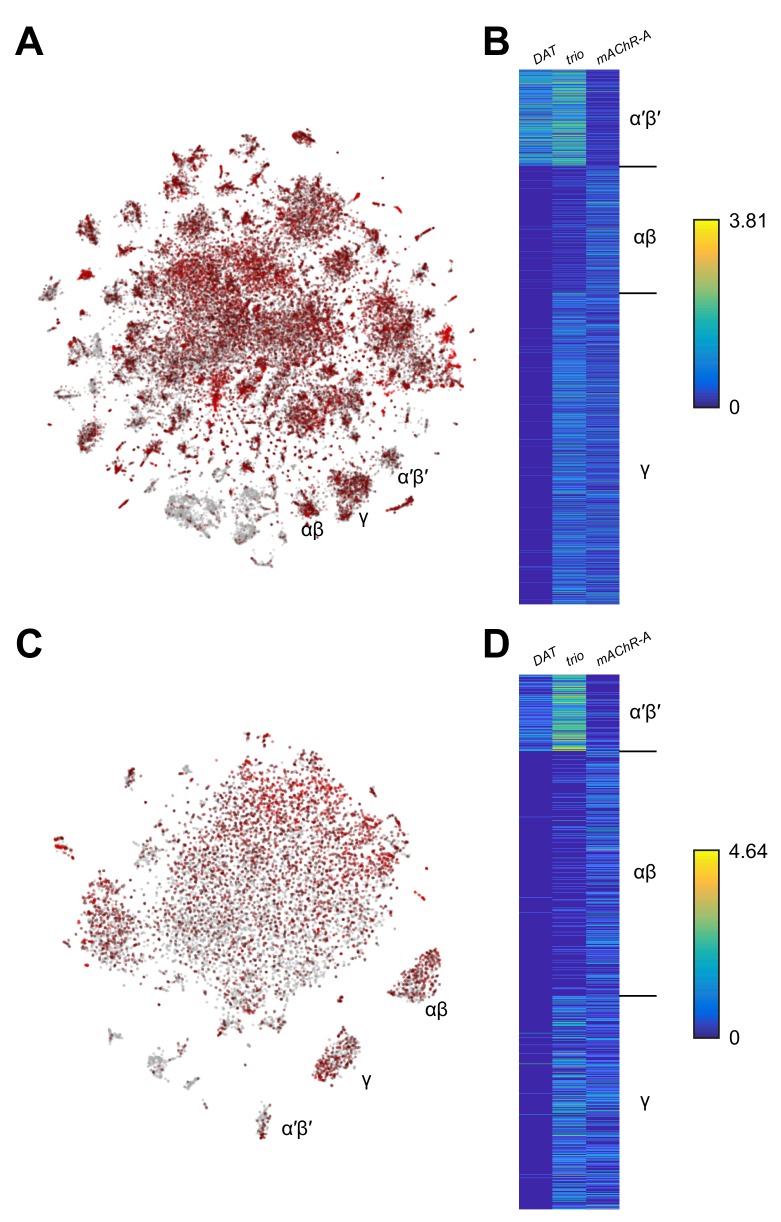
Expression of mAChR-A from single-cell transcriptome profiling.(A) Data from Davie et al. (2018). 56,902 Drosophila brain cells arranged according to their single-cell transcriptome profiles, along the top two principal components using t-SNE. Red coloring indicates expression of mAChR-A. KC subtype clusters are labeled as identified in Davie et al. (2018). (B) Expression of DAT (marker for α′β′ KCs), trio (marker for α′β′ and γ KCs), and mAChR-A for cells identified as α′β′, αβ and γ KCs in Davie et al. (2018). mAChR-A expression is higher in αβ and γ KCs compared to α′β′ KCs. (C) As in A but with data from Croset et al. (2018) (10,286 Drosophila brain cells). (D) As in B but with data from Croset et al. (2018). Images screenshotted and raw data downloaded from SCope (http://scope.aertslab.org) on 24 June 2018.